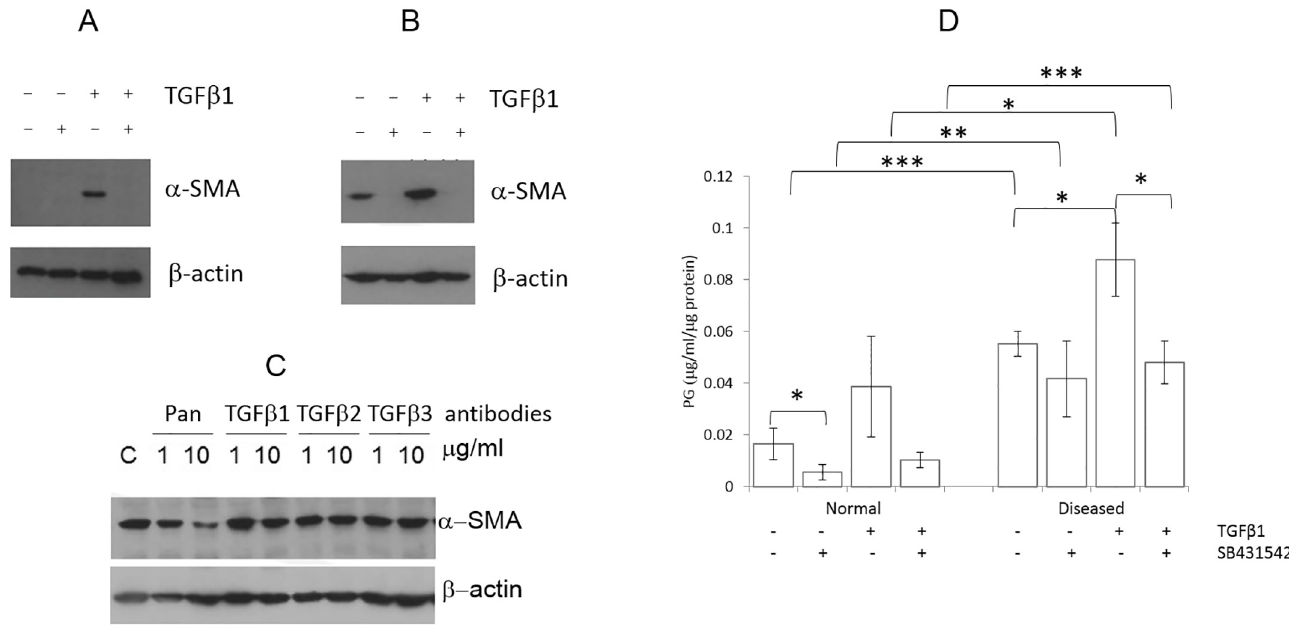
Fig 4. Pharmacological manipulation of α SMA expression. Protein immunoblotting illustrating: (A) Changes in α SMA expression in normal cells treated with vehicle, 5ng/ml of TGF β 1 and 10 μ M of SB431542 (B) Abolition of α SMA expression in diseased cells by SB431542. (C) Reduction in α SMA expression in diseased cells by treating with a pan anti-TGF β antibody at 10 μ g/ml, but not by TGF β specific antibodies. (D) Changes in deposition of proteoglycans (PG) in normal and diseased cells in response to TGF β 1 and SB4341542. Statistical analysis was performed with Student’s t-test. � , �� , and ��� P < 0.5, 0.1 and 0.01 respectively.